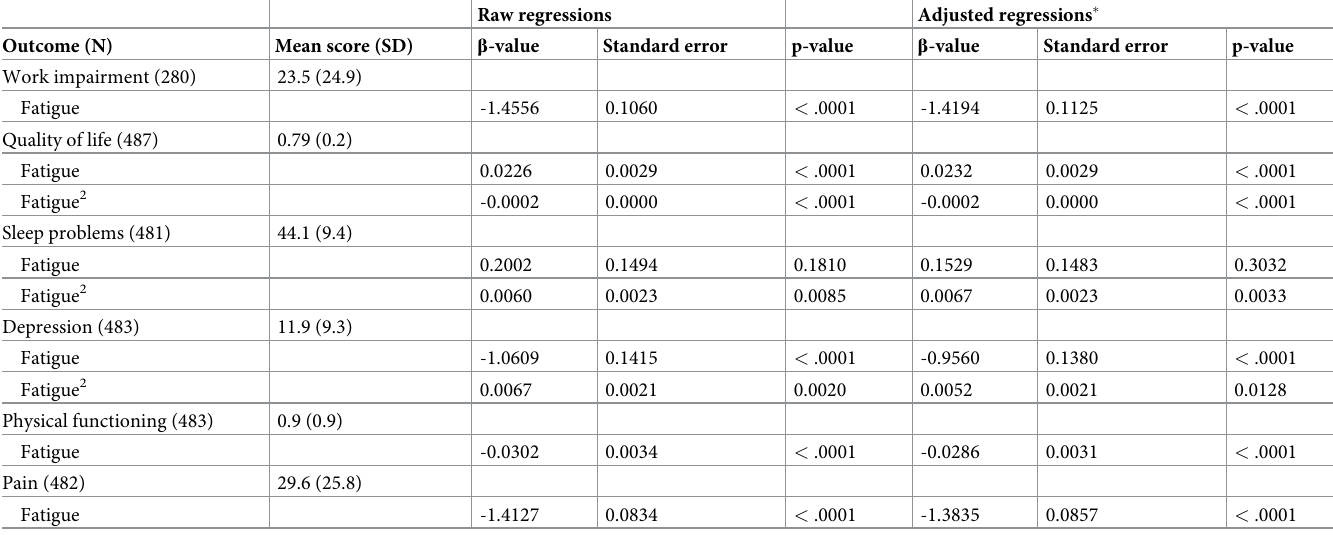
Table 3. Means and raw and adjusted linear regressions for the association between fatigue and work impairment, quality of life, sleep problems, depression, physi- cal functioning and pain,